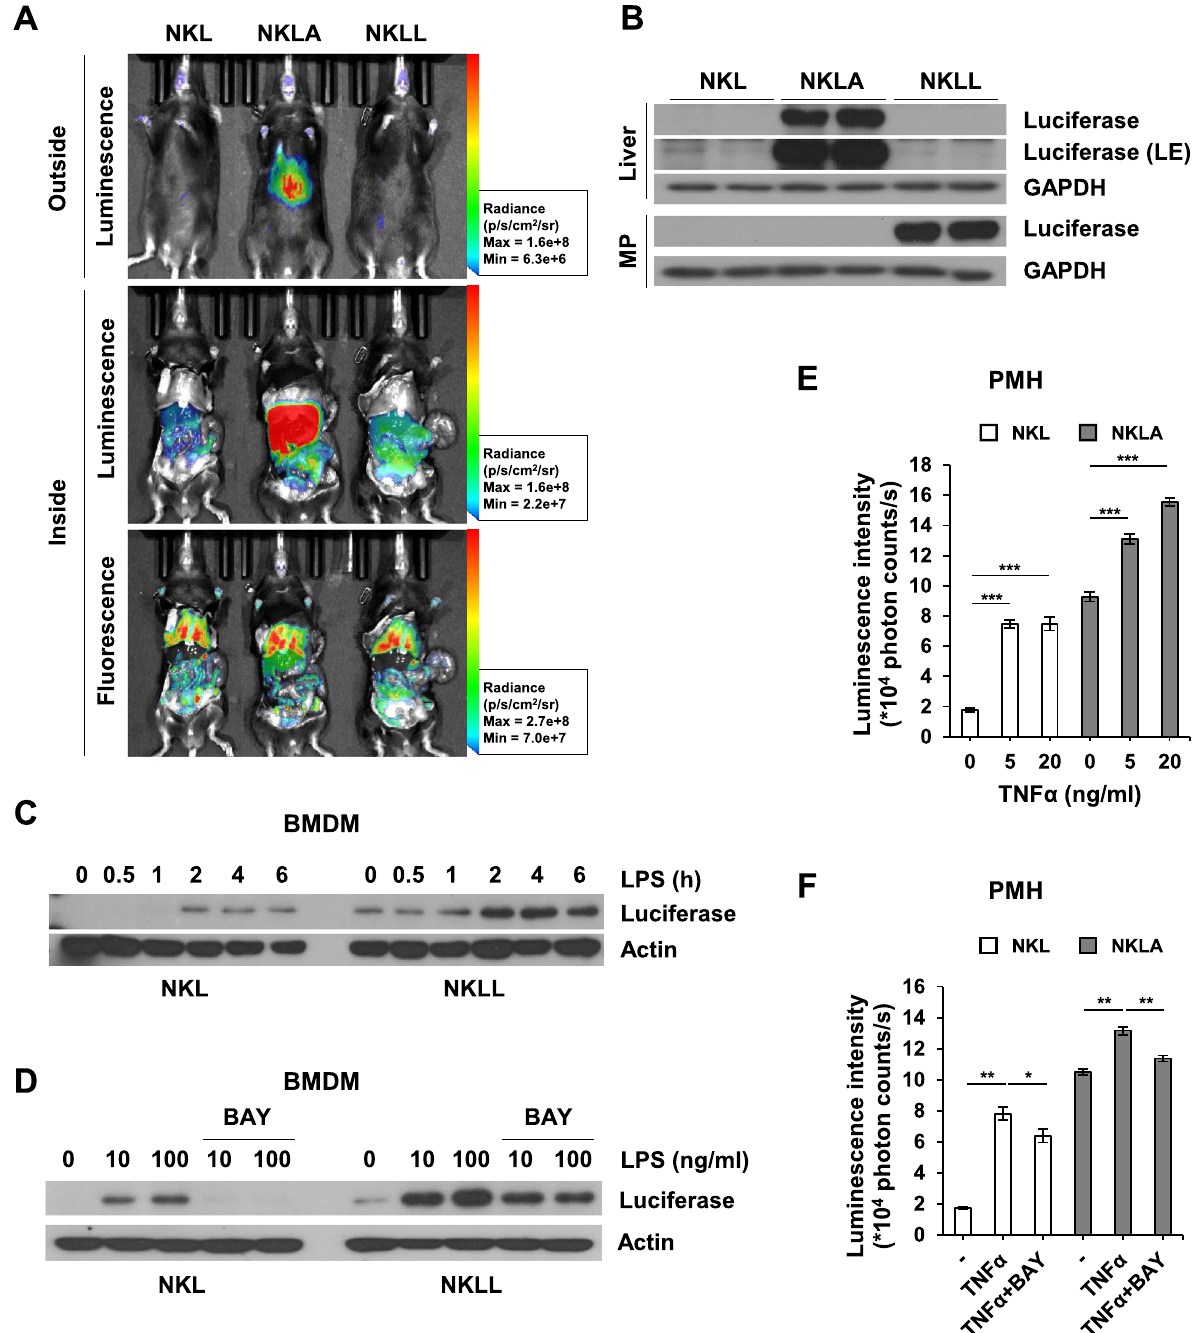
Figure 3. Generation of cell-type specific enhanced reporter mice and its ex vivo applications. ( A ) Comparison of bioluminescence and fluorescence among genotypes. Radiance ranges of parameters are provided in the figure. ( B ) Luciferase levels in liver and peritoneal macrophages isolated from NF-κB-Luc mice (NKL), NF-κB-Luc:Alb mice (NKLA), and NF-κB-Luc:Lyz2 mice (NKLL). LE; long exposure. ( C , D ) Luciferase levels in BMDMs isolated from NKL or NKLL. BMDMs were treated with LPS (100 ng/ml) for different times ( C ) or co-treated with LPS (100 ng/ml) and BAY 11–7085 (10 μM) for 6 h ( D ). Protein expressions were detected by western blotting. ( E , F ) Luminescence intensities of primary mouse hepatocytes (PMHs) isolated from NKL or NKLA. PMHs were treated with TNFα (5 or 20 ng/ml) ( E ), or co-treated with TNFα (20 ng/ml) and BAY 11–7085 (10 μM) for 24 h ( F ). Luminescence intensities were measured using microplate reader, and results are presented as means ± SEMs (n = 5). * p < 0.05, ** p < 0.01, *** p < 0.001. MP peritoneal macrophage, BMDM bone marrow-derived macrophage, PMH primary mouse hepatocyte. All western blot images were cropped from the original films presented in Supplementary